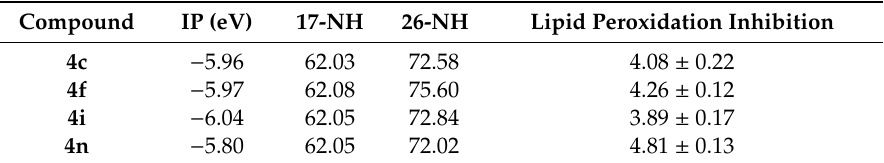
Table 4. Bond dissociation enthalpies (BDEs) (kcal / mol) of i-NH groups of the indolin-2-ones (In-H) synthesized derivatives and its corresponding ionization potential energies calculated at the B3P86 / 6-31 + G(d,p) level of